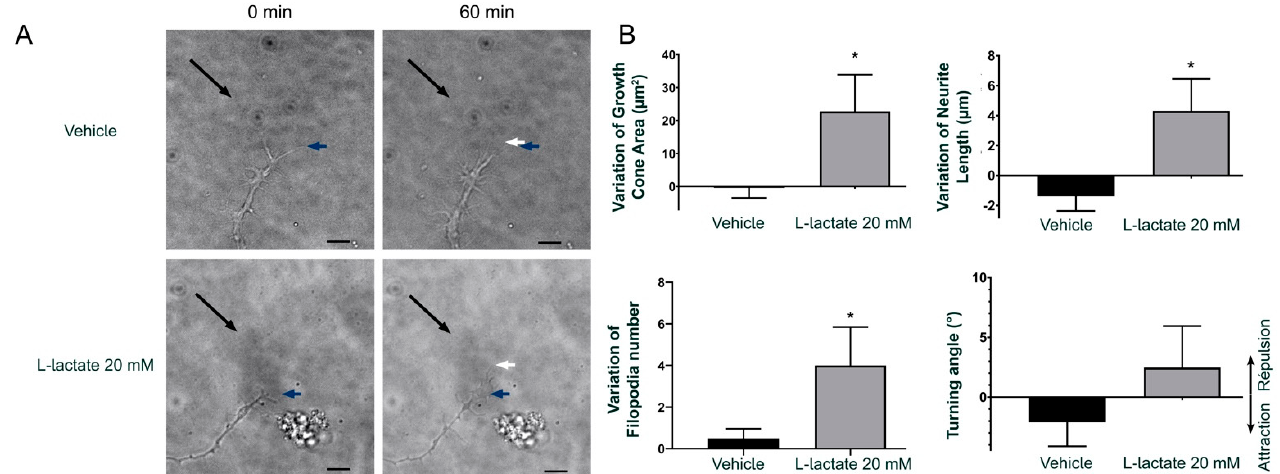
Figure 3. L-lactate influences GC morphology and axon growth, but not turning. ( A ) Time-lapse microscopy time of a DIV1-2 mouse RGC growth cone before and at 60 min after the addition of L-lactate. The black arrows indicate the microgradient direction created by a micropipette with a tip of 2 µ m diameter and positioned at a 45 ◦ angle and around 100 µ m distal to the growth cone. The blue arrows indicate the tips of the growth cone before the application of L-lactate or vehicle (T0). The white arrows indicate the position of the growth cone 60 min later (T60). ( B ) Analysis of growth cone dynamics. The values of the growth cone area, filopodia number on the growth cone, axon length, and the angle of the growth within the L-lactate microgradient were measured before (T0) and at 60 min (T60) after the addition of L-lactate or vehicle. Bar graphs show the means ± SEM of the effects induced by the treatments ( n = 6–8 cells per condition). * Indicates significant changes compared to the vehicle group, compared by parametric unpaired t -test ( p < 0.05). Scale bar = 15 μ m.